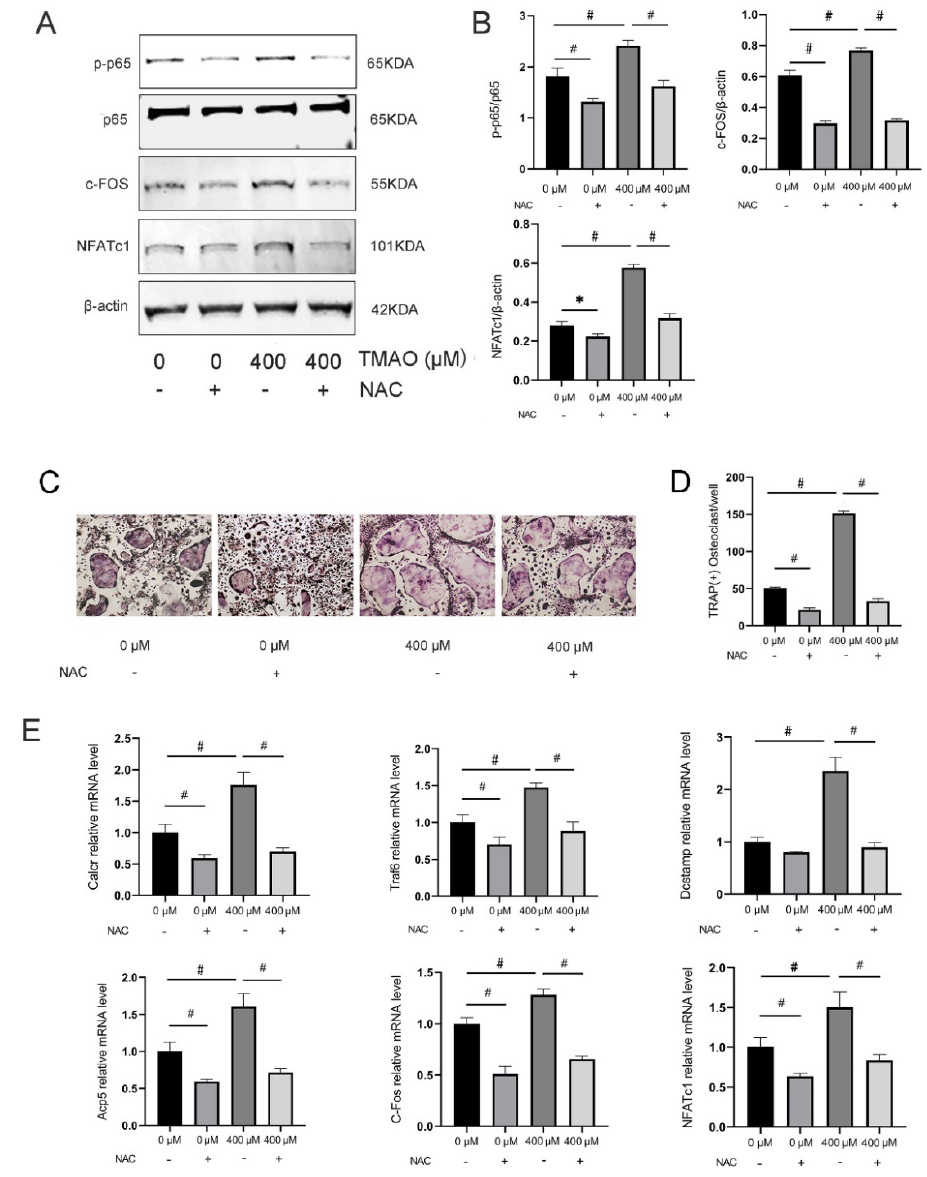
Figure 6. Inhibition of ROS by NAC suppressed TMAO-induced NF- κ B activation. ( A , B ) The phosphorylation of p65, and the protein expression levels of c-Fos, NFATc1 were promoted under 400 µ M TMAO and suppressed by NAC with or without TMAO treatment as examined by Western blot ( n = 3 per group). ( C , D ) BMMs were pretreated with 30 mM NAC for 1 h before being cultured with or without 400 µ M TMAO. The numbers of TRAP-positive osteoclasts increased with 400 µ M TMAO and decreased with NAC pretreatment with or without TMAO. Scale bar = 20 µ m. ( E ) The expression of the osteoclast-specific genes was promoted under 400 µ M TMAO and suppressed by NAC with or without TMAO treatment as evaluated by real-time PCR ( n = 3 per group). * p < 0.05, # p < 0.01.